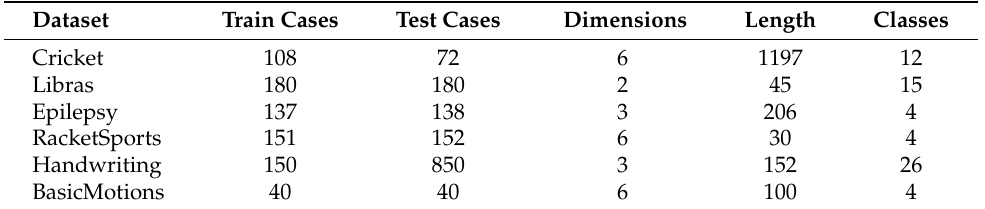
Table 8. Summary of the six datasets from the UEA multivariate time series classification archive.